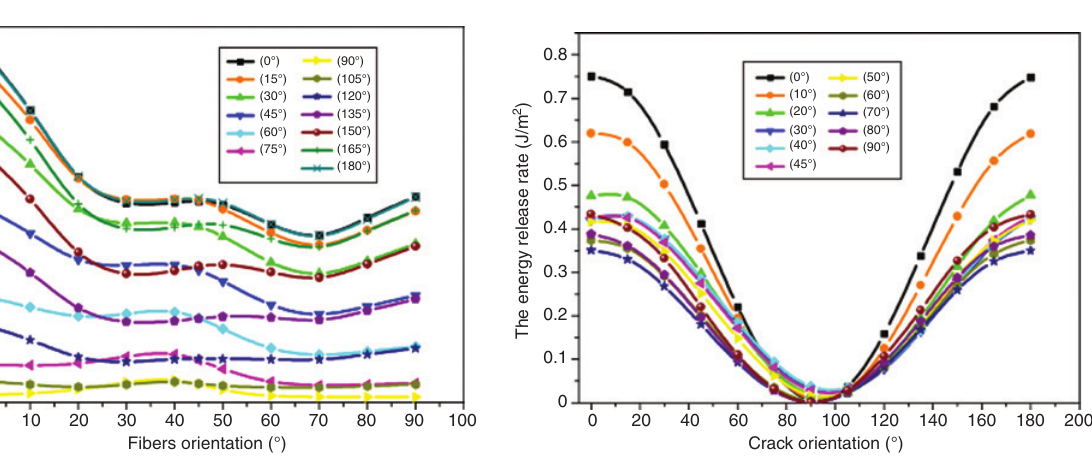
Figure 10: Variation of the energy release rate in function of the fiber orientation for all orientations of the crack in the case where the two circular notches are inclined at an angle of 45 °